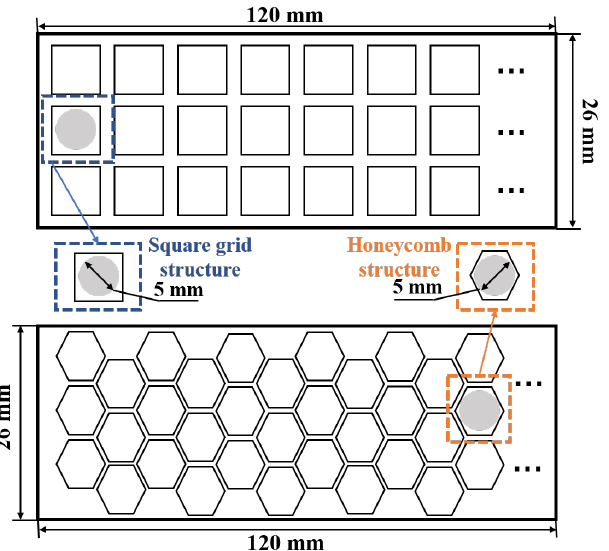
Figure A1. Comparison of the number of PTFE balls accommodated between square-grid structure and honeycomb structure.